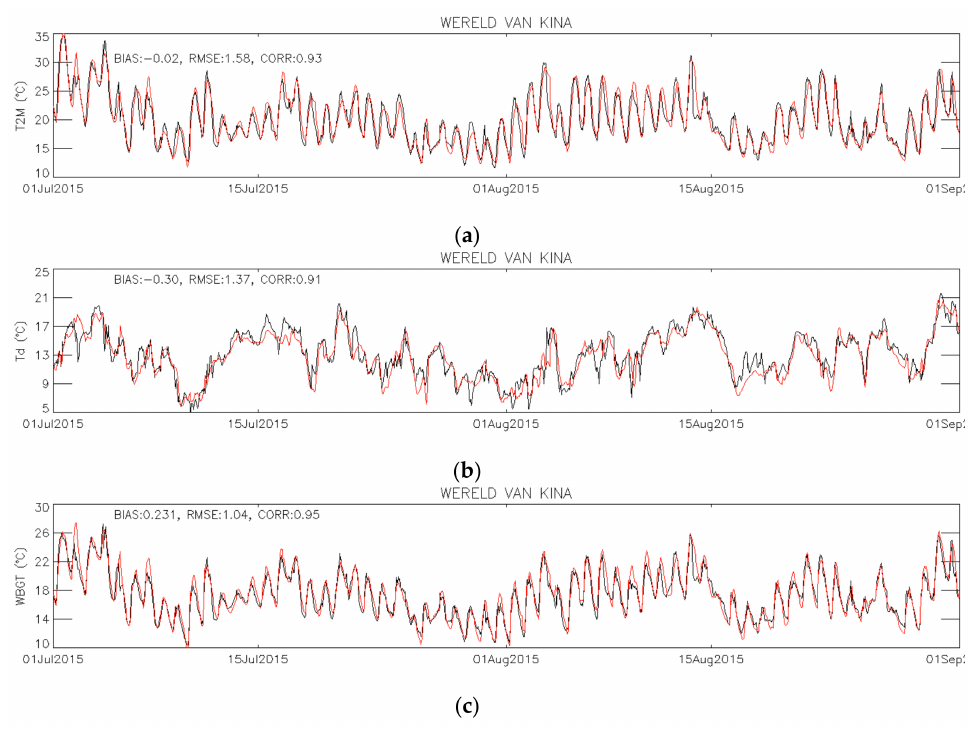
Figure 2. Time series of 2 m air temperatures ( a ), 2 m dew point temperatures ( b ), and wet bulb globe temperatures ( c ) for July and August 2015. Observations are in black, model results in red. The quantities given are the bias, root mean square error (RMSE), and correlation coe ffi cient